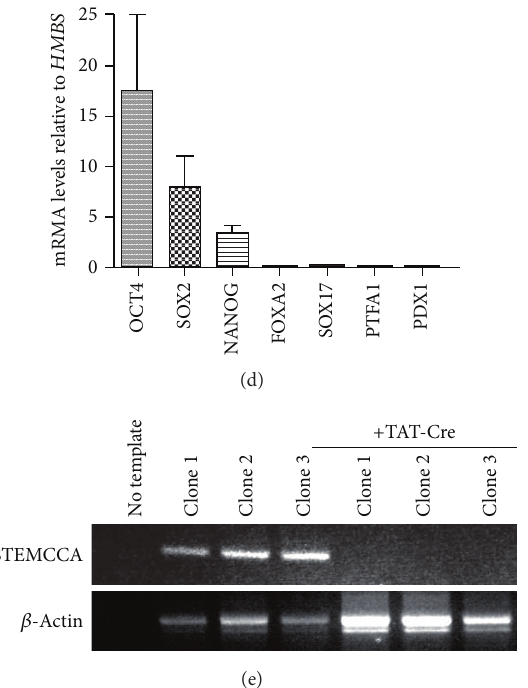
Figure 1: Generation of human induced pluripotent stem cells. (a) Scheme of reprogramming keratinocytes from human plucked hair into induced pluripotent stem cells (hiPSCs). Bright field microscopy images from outgrowing keratinocytes, in detail, the outer root sheath of a plucked human hair. Keratinocytes were infected with a lentiviral construct containing the reprogramming factors OCT4, SOX2, KlF4, and cMyc on two subsequent days. On the following day keratinocytes were transferred onto a monolayer of irradiated REFs (rat embryonic fibroblasts) and after some days small hiPSC colonies could be detected. For later passaging hiPSCs were cultured, under feeder- free conditions, on Matrigel-coated dishes in FTDA medium. Scale bars are 20 𝜇 m. (b) hiPSCs express the nuclear factors OCT4, SOX2, and NANOG as well as the pluripotent surface markers SSEA4, TRA-1-60, and TRA-1-81 ( all red ). Scale bars as indicated. (c) hiPSCs used in the present study are capable of differentiating into cells of all 3-germ layers represented by 𝛽 -tubulin (beta-tubulin 3 in green, neurons— ectoderm), 𝛼 -actinin (alpha-actinin in green, myocytes—mesoderm), and AFP (alpha-fetoprotein in green, liver cells—endoderm). Nuclei are stained with DAPI in blue. (d) Transcript levels of pluripotent markers such as OCT4 , SOX2, and NANOG were highly expressed whereas markers for definitive endoderm ( SOX17 and FOXA2 ) and markers for pancreatic progenitor cells ( PTFA1 and PDX1 ) were not expressed at all. (e) Polymerase chain reaction to detect the STEMCCA cassette in iPS cell subclones before and after treatment with recombinant Cre protein (actin band ∼ 480 bp, STEMCCA band ∼